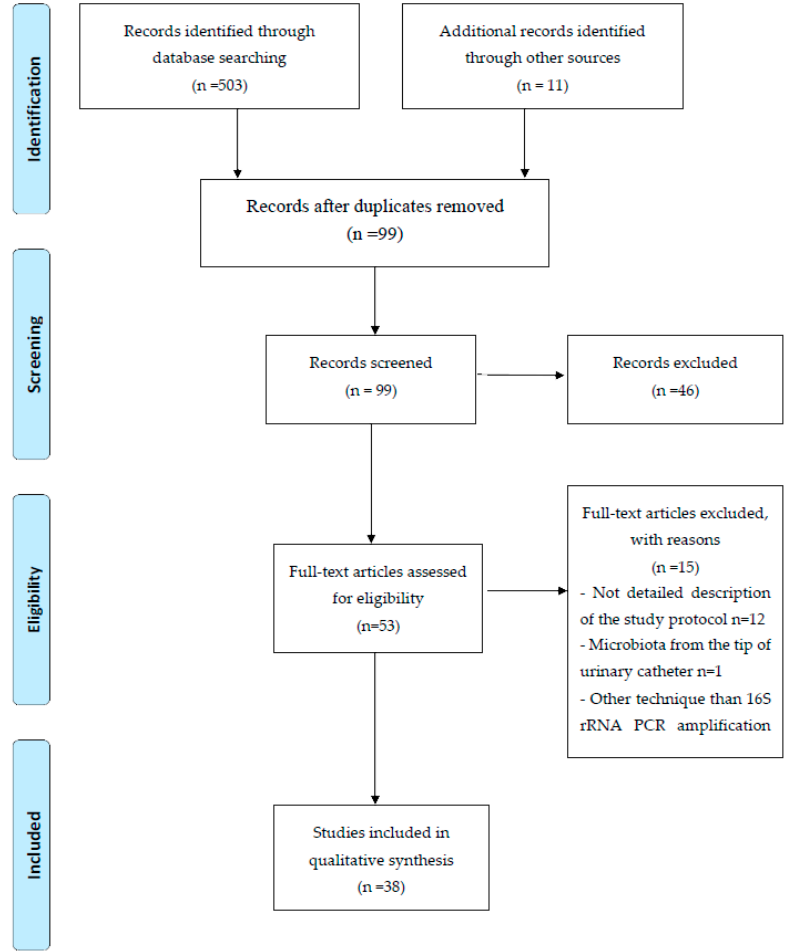
Figure 1. Reporting Items for Systematic Reviews and Meta-Analysis (PRISMA) flowchart of Figure1. literature search.